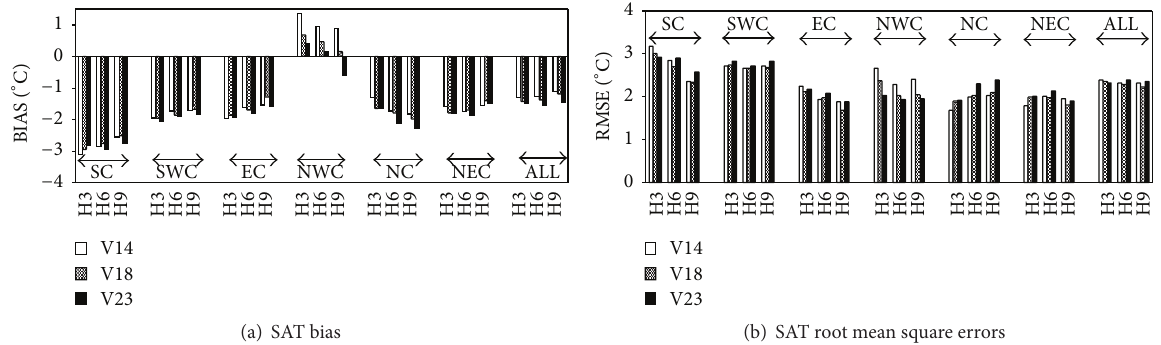
Figure 3: BIAS (a) and RMSE (b) of summer-mean SAT for the studied subareas (South China (SC), Southwest China (SWC), East China (EC), Northwest China (NWC), North China (NC), Northeast China (NEC), and total area